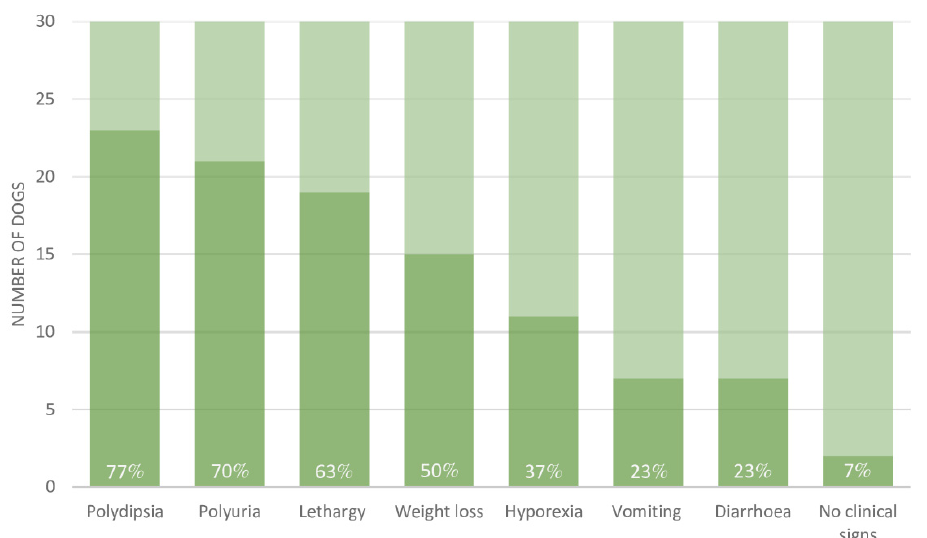
Figure 3 . Para-clinical findings in 30 dogs diagnosed with jerky induced Fanconi syndrome. Para- clinical findings reported in medical records from attending veterinarians for 30 dogs diagnosed with acquired Fanconi syndrome associated with ingestion of jerky treats. All dogs were included due to confirmed normoglycemic/hypoglycemic glycosuria. The dark color represents the number